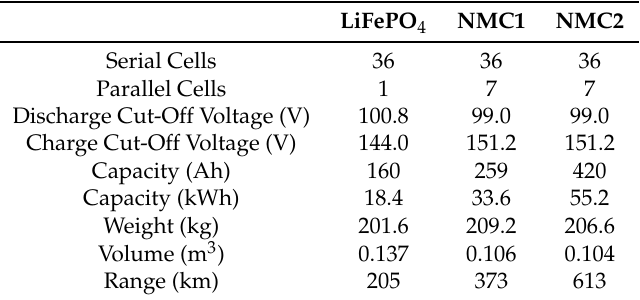
Table 4. Specification of the battery packs proposed for VEECO